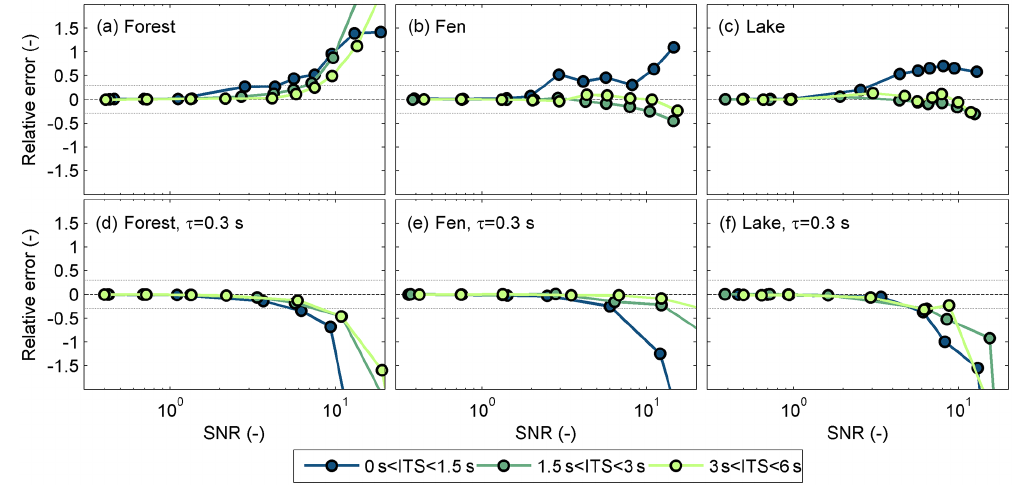
) and the actual ( σ 2 ) signal noise variance as a function of SNR and ITS calculated Figure 6. Relative difference between the estimated ( ˆ σ 2 n,f n,f as z − d , where n m was found according to Eq. (3). The data were bin averaged before plotting. The values for τ in the subplots show the 2 πn m U time constant used in low-pass (auto-regressive) filtering of the original temperature time series (i.e. before superimposing the noise). The dashed lines highlight the zero line (no systematic error in the noise estimate), whereas the dotted lines show the ± 30% thresholds. The top row shows data with no low-pass filtering.